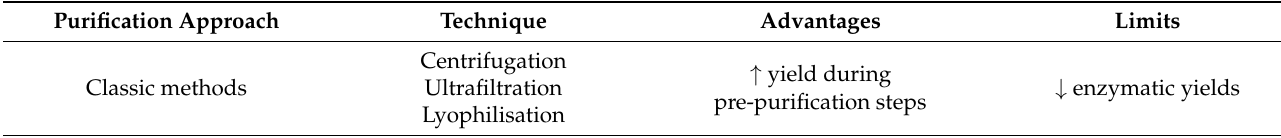
Table 4. Advantages and limits of bromelain purification using classic or unconventional